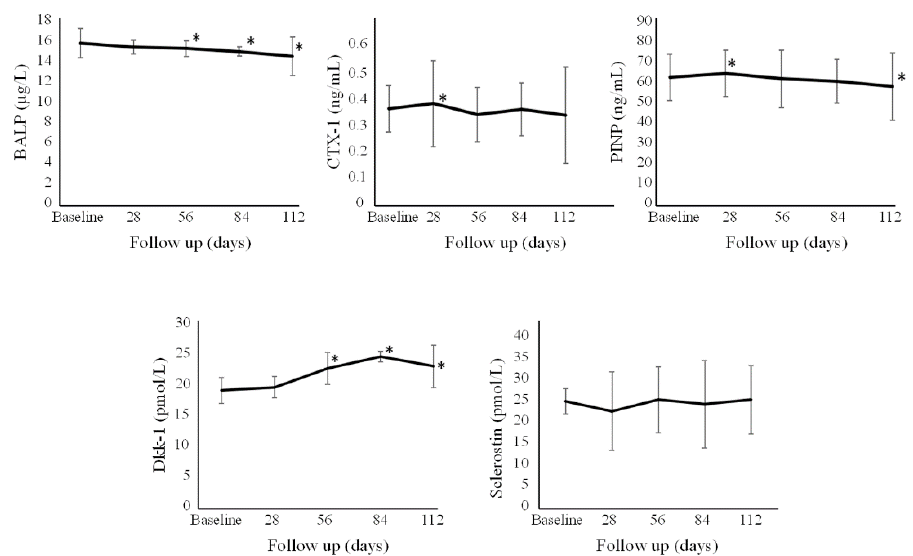
Figure 3. Absolute changes of the overall cohort of BALP, CTX-I, PINP, Dkk-1, and sclerostin. * p < 0.05 with respect to with respect to baseline. Error bars denote standard deviation. BALP = bone alkaline baseline. Error bars denote standard deviation. BALP = bone alkaline phosphatase; CTX-I = C-terminal telopeptide of type I collagen; DKK-1 = Dicckopf-1; PINP = procollagen type I N-terminal propeptide.